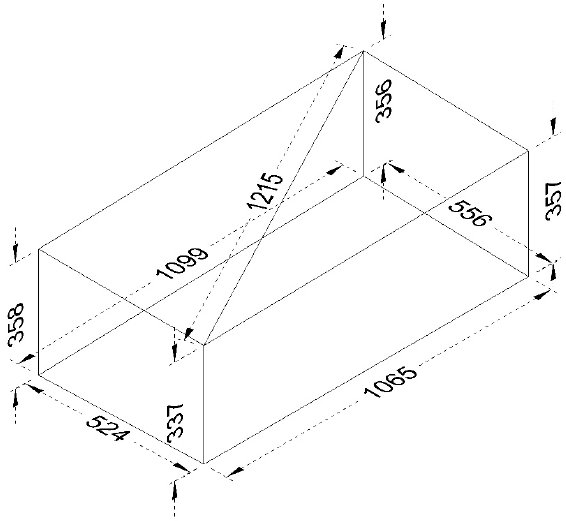
Table 7. Calculation of the thermal conductivity of the specimen SB01.